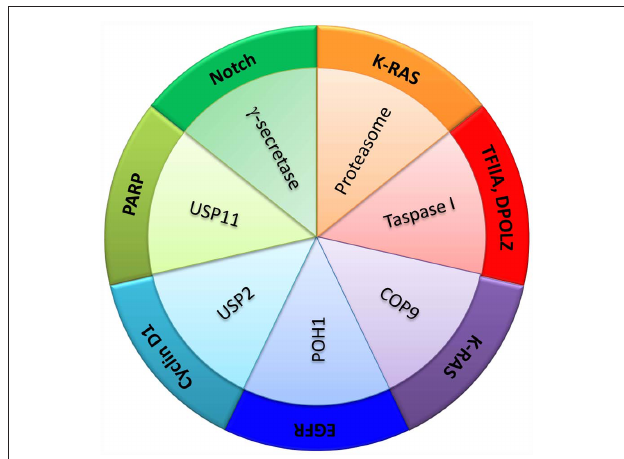
Figure 3 | Functional interactions between proteases and cancer genes in the context of protease addiction processes in cancer. Several examples of proteolytic activities are shown in relation with different proteins involved in cancer development and survival, as discussed in the main